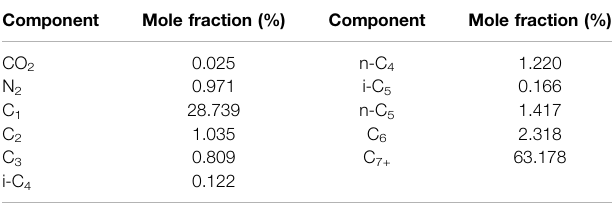
TABLE 1 | The composition data of crude oil components. Component Mole fraction